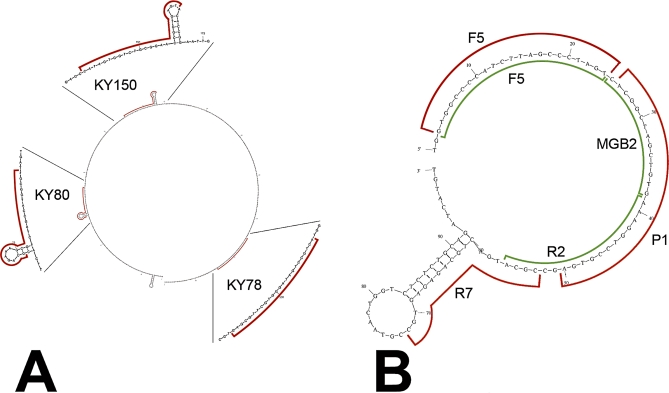
Secondary Structure PredictionsSecondary structure of the HCV 5′-NCR (A) and the 3′-X-tail (B) of HCV 1a reference genome H77 as predicted by MFOLD [43]. Prediction was done at 50 mM salt concentration and PCR primer annealing temperature (58 °C). Free energies ΔG were −1.6 × 10−3 J/mol for (A) and −5,06 × 10−4 J/mol for (B). 5′-NCR structure predictions were identical for all genotypes in the LANL genotype reference panel except genotype 2, which had one additional stem-loop element (not covered by primers, not shown in [A]). Structure predictions for all X-tail sequences (database and new sequences) were identical (not shown in [B]).(A) Binding sites of oligonucleotides used by the Roche Amplicor assay are shown in red (sense primer KY80, hybridization probe KY150, antisense primer KY78). Nucleotide variability at these binding sites is shown in Text S2).(B) Outer lines in red identify the hybridization sites of oligonucleotides used in initial X-tail RT-PCR set, yielding limited sensitivity (forward primer F5, TaqMan probe P1, reverse primer R7). Interior lines in green identify the final X-tail prototype assay (forward primer F5, reverse primer R2, probe MGB2). Nucleotide variability at these sites is shown in Text S2.